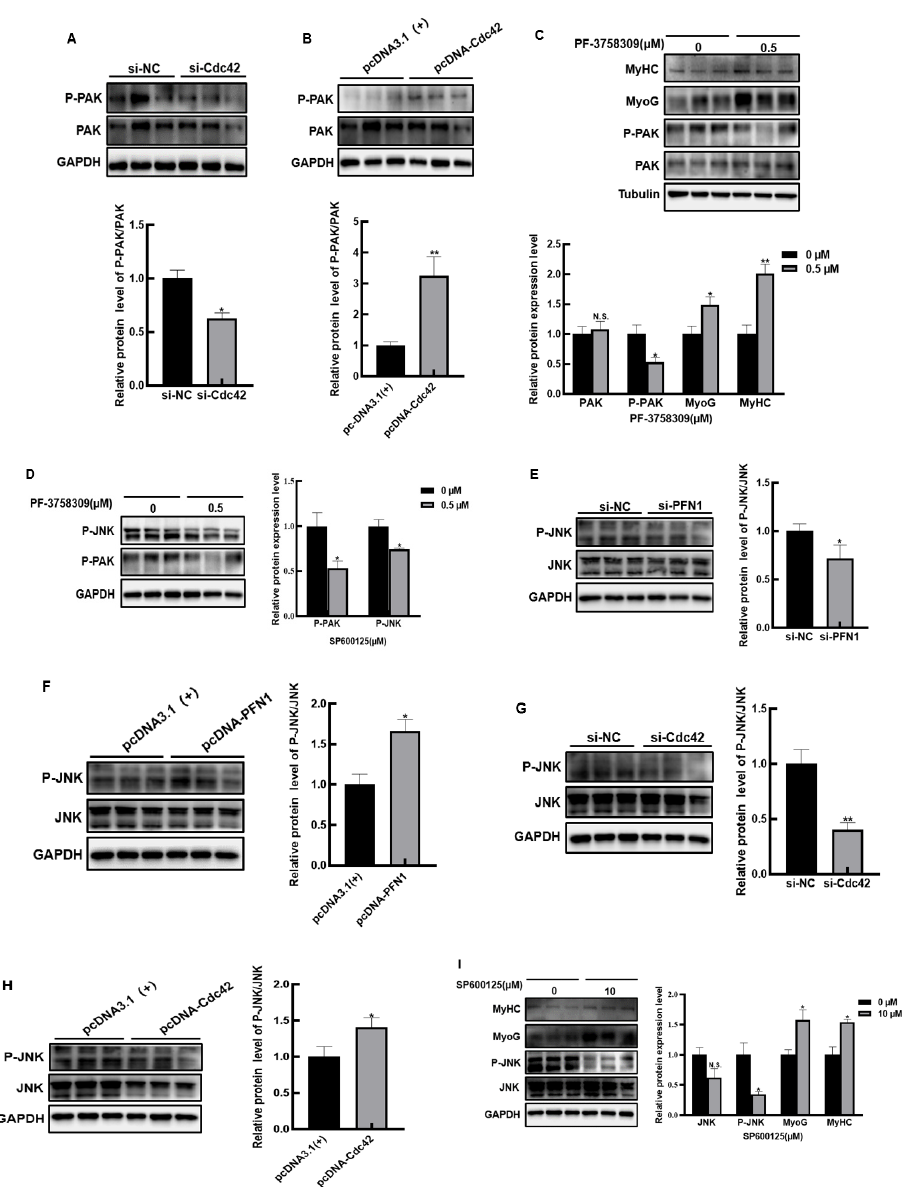
Figure 4. PFN1-Cdc42 negatively regulates bovine skeletal muscle via PAK/JNK signaling pathway: ( A ) Western blot testing and quantitative analysis of the effect of Cdc42 on PAK phosphorylation in si-Cdc42 or si-NC transfected DM2 myoblasts; ( B ) Western blot testing and quantitative analysis of the effect of Cdc42 on PAK phosphorylation in pcDNA-Cdc42 or pcDNA3.1(+) transfected DM2 myoblasts; ( C ) changes analysis of differentiation marker proteins of the DM2 bovine myoblasts with P-PAK inhibitor by Western blot; ( D ) protein level analysis of P-JNK after P-PAK inhibition in DM2 bovine myoblasts by Western blot; ( E ) Western blot detecting and quantitative analysis of the effect of PFN1 on the JNK signal pathway in si-PFN1 or si-NC transfected DM2 myoblasts; ( F ) Western blot detecting and quantitative analysis of the effect of PFN1 on the JNK signal pathway in pcDNA-PFN1 or pcDNA3.1(+) transfected DM2 myoblasts; ( G ) Western blot detecting and quantitative analysis of the effect of Cdc42 on the JNK signal pathway in si-Cdc42 or si-NC transfected DM2 myoblasts; ( H ) the effect analysis of Cdc42 on the JNK signal pathway in pcDNA-Cdc42 or pcDNA3.1(+) transfected DM2 myoblasts; ( I ) change analysis of differentiation marker proteins of the DM2 bovine myoblasts with JNK inhibitor. si-NC stands for negative control, and pcDNA3.1(+) stands for empty vector control negative control. N.S.: non significance, * p < 0.05, ** p <